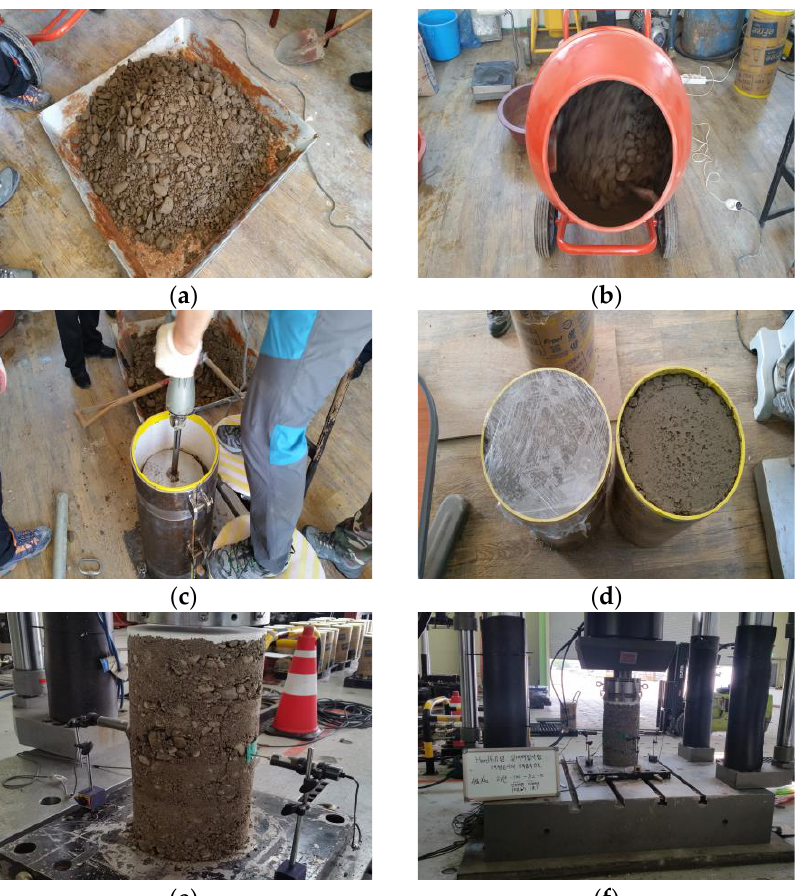
Figure 2. Preparation of a large specimen for unconfined compressive strength test. ( a ) Material placement; ( b ) material mixing; ( c ) sample compaction; ( d ) sample curing; ( e ) large specimen; ( f ) uniaxial compressive strength test.